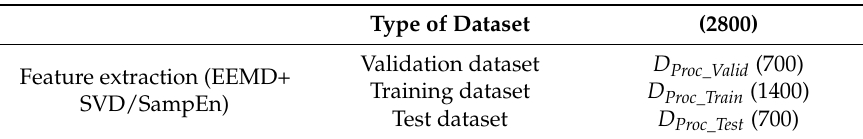
Table 3. Division of the acquired